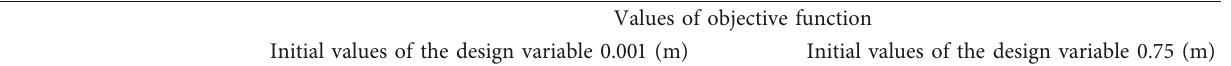
0 , 100 Hz and the initial values of the design variables 0.001. (b) f (cid:31) [ ] 100 , 1000 Hz and the initial values of the design variables 0.001. (d) f (cid:31) [ ] Values of objective